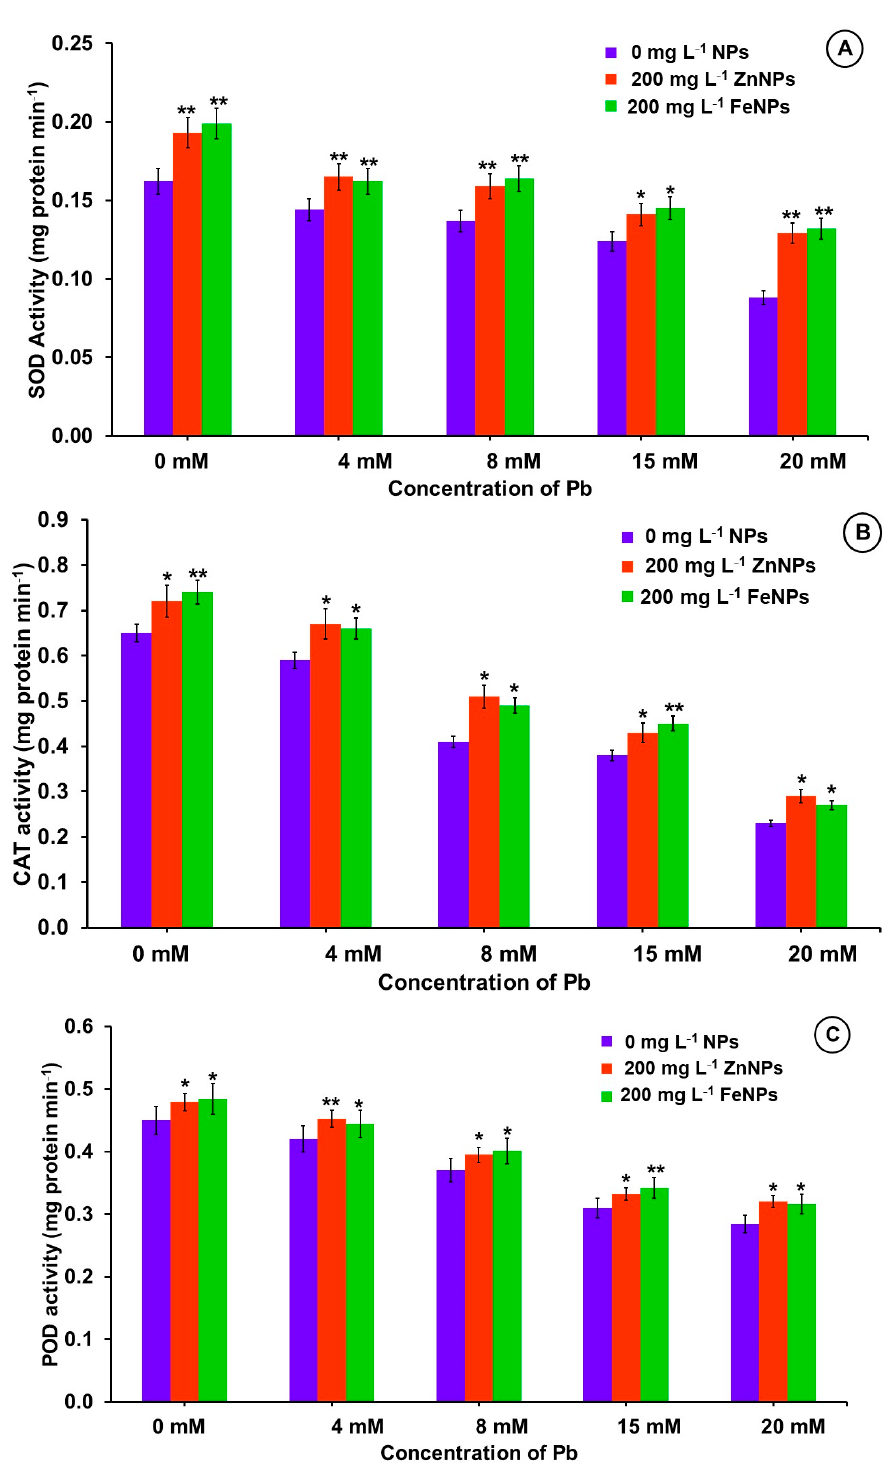
Figure 6. Effects of Pb and nanoparticles (Zn- and Fe-NPs) on ( A ) SOD, ( B ) CAT and ( C ) POD activity of 20-day-old B. alba seedling. Error bars representing the standard error. Asterisks above the error bars denote significant differences between treatments in comparison to respective treatment without NPs (* = p value < 0.05 and ** = p value < 0.01, Duncan’s Multiple Range Test). NPI score estimated for the studied parameters indicated that FeNPs has a high NPI score under various Pb treatments over ZnNPs, indicating the superiority in alleviating Pb stress in the treated seedlings. In case of 20 mM Pb + 200 mg L − 1 ZnNPs treatment the obtained score was 0.110 and the score of the 20 mM Pb + 200 mg L − 1 FeNPs treatment was 0.116, indicating the superiority of FeNPs in alleviating Pb stress (Table 1). The t -test of